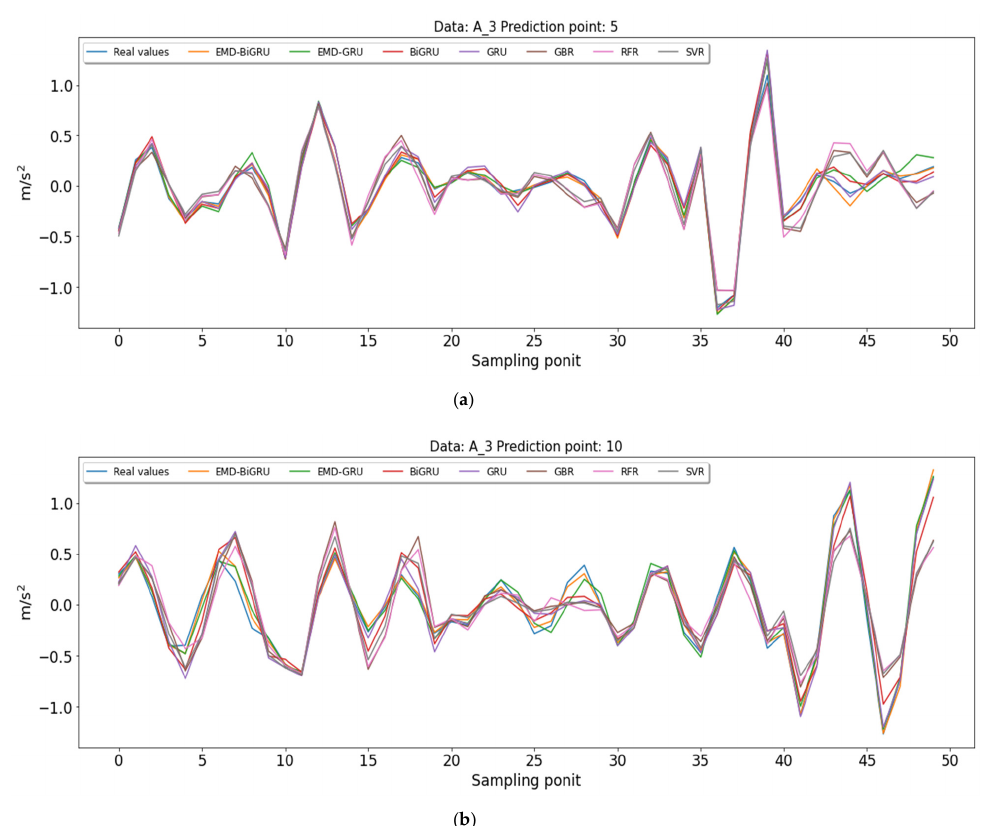
Table A2. Comparison results for data set A_3 using different algorithms.